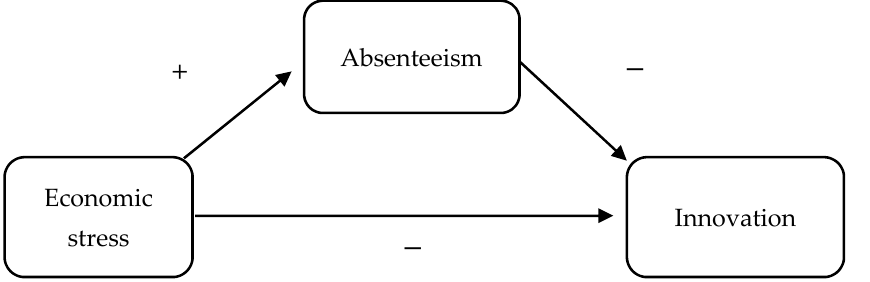
Figure 1. Mediation model proposed to test the associations between economic stress, absenteeism and